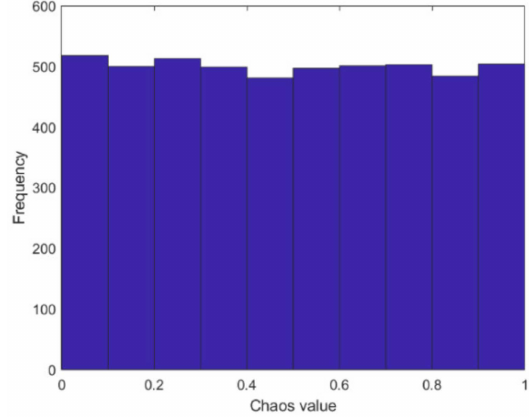
Figure 11. Frequency distribution diagram of random number.